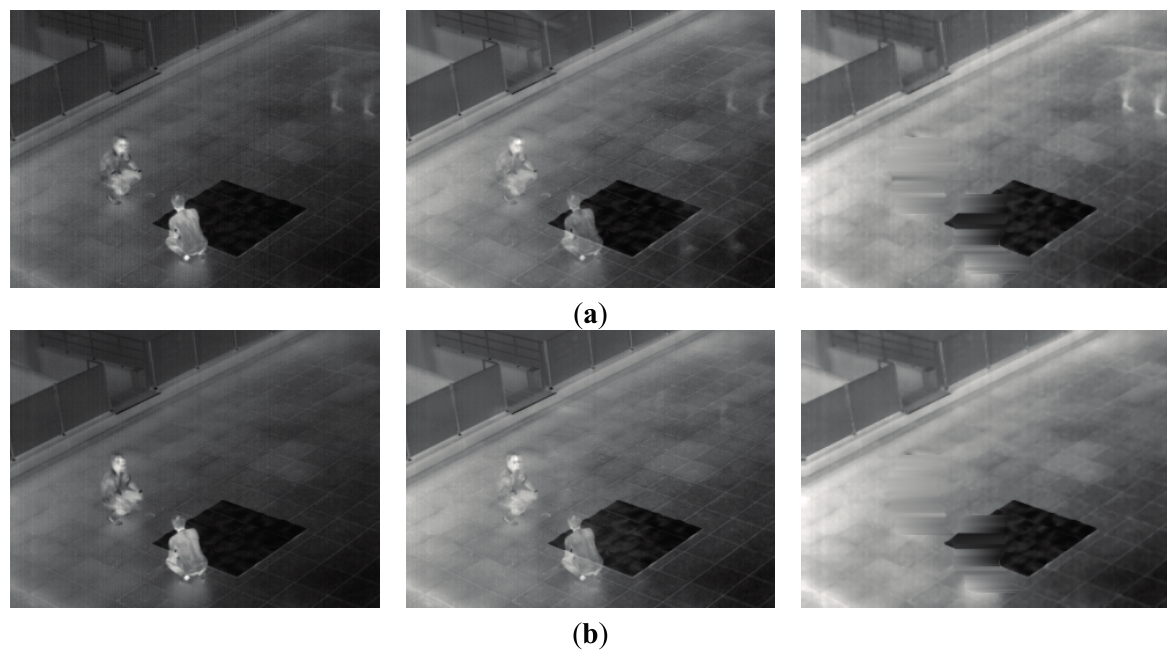
Figure 12. Comparisons of generated background images with our database (second database). The left, middle and right figures of ( a , b ) are by simple temporal averaging operation [28], averaging the frames in two difference sequences [26] and the proposed method, respectively: ( a ) with Sequence 4 of [28] (left figure) and the proposed method (right figure) and with Sequences 4 and 1 of [26] (middle figure); ( b ) with Sequence 5 of [28] (left figure) and the proposed method (right figure) and with Sequences 5 and 2 of [26] (middle